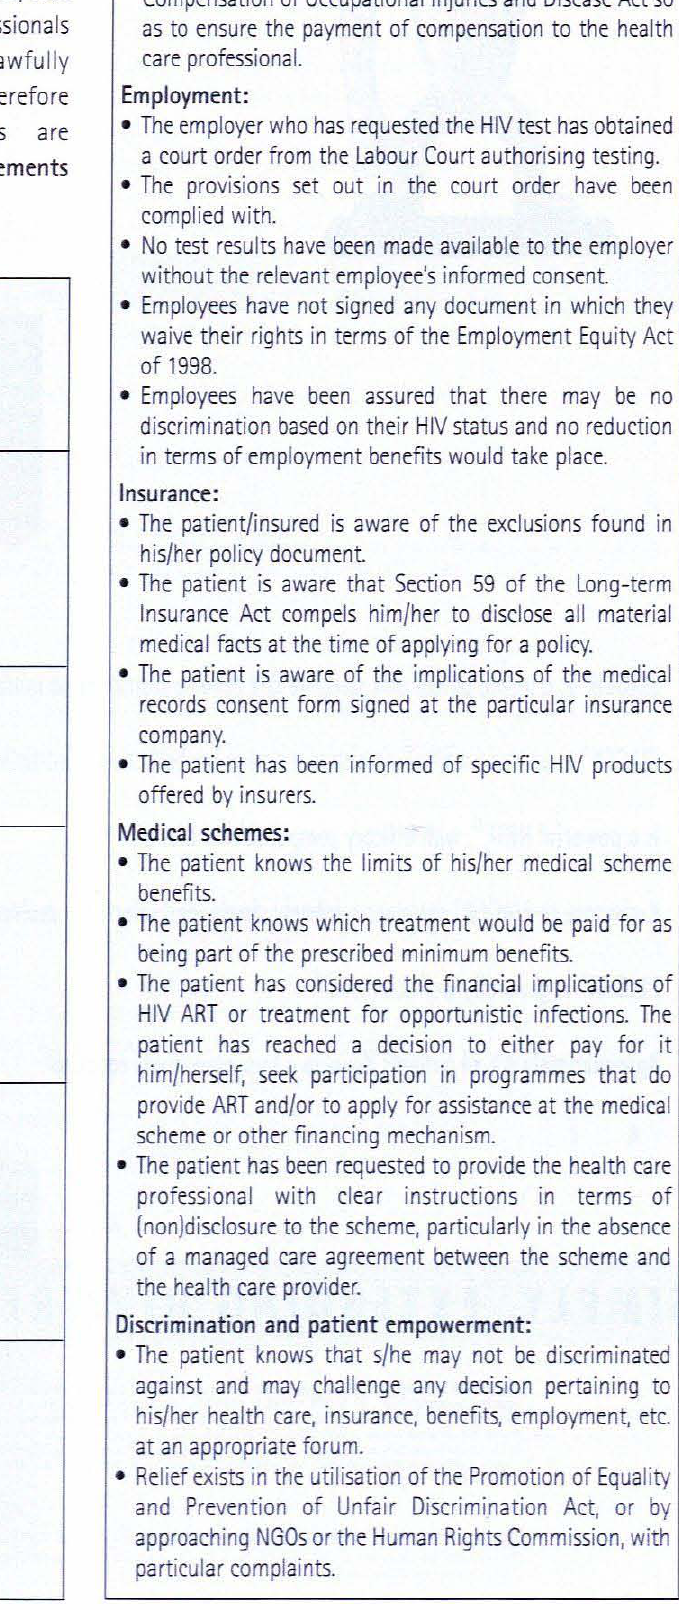
applicable to these